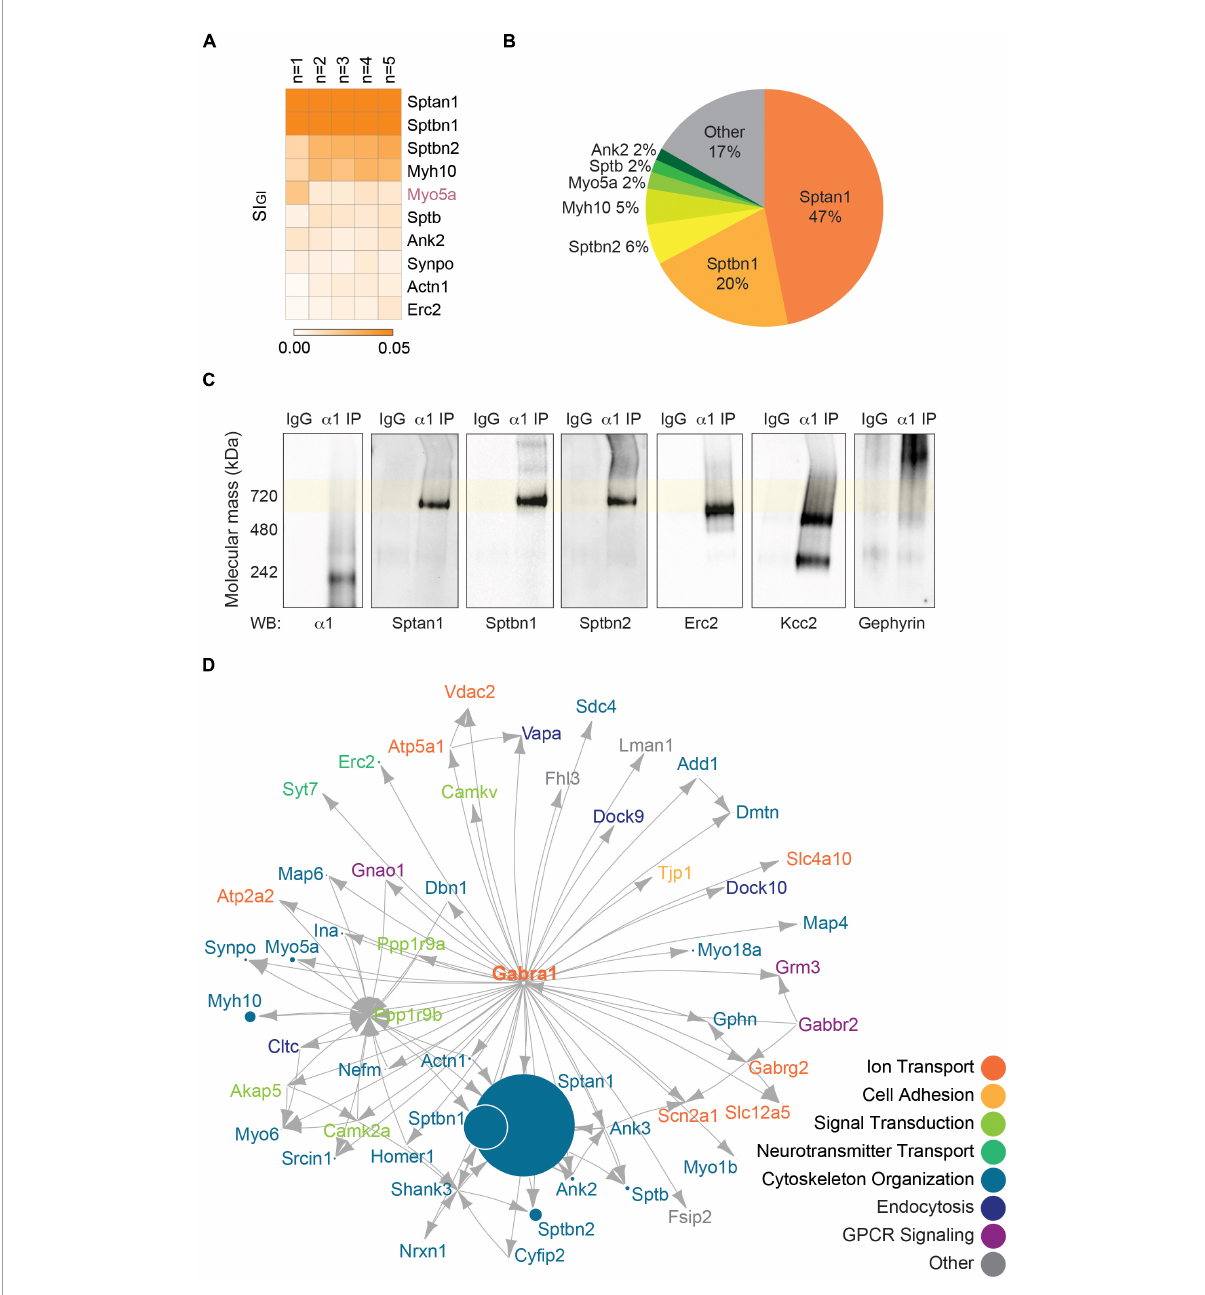
FIGURE2 The endogenous α 1 subunit interacts with inhibitory scaffolding proteins and cytoskeletal proteins. (A) The 720 kDa band of α 1-containing GABA A Rs purified from PM was subjected to LC-MS/MS. Label-free normalized quantification and Welch’s t -test against non-immune control IgG revealed 93 significantly enriched binding proteins of the α 1 subunit. The heatmap shows the top 10 binding proteins of α 1-containing GABA A Rs by abundance (SI GI value) across all replicates. The most abundant proteins detected with the α 1 subunit are Sptan1, Sptbn1, and Sptbn2 ( n = 5 replicates). (B) Pie chart shows the relative abundance of the proteins that are significantly enriched with α 1-containing GABA A Rs. Sptan1, Sptbn1, and Sptbn2 together constitute more than 70% of the total amount of proteins. Proteins that make up less than 2% of the total amount of proteins (86 proteins) were grouped together as ‘Other.’ (C) Immunopurified α 1-containing GABA A Rs were resolved on BN-PAGE and probed for the α 1 subunit, high-abundance proteins (Sptan1, Sptbn1, and Sptbn2), and low-abundance proteins (Erc2, Kcc2, and gephyrin). Sptan1, Sptbn1, and Sptbn2 are observed at around 720 kDa with α 1-containing GABA A Rs. Erc2 and Kcc2 are present slightly below 720 kDa and gephyrin is observed higher than 720 kDa. The immunoreactivity of these proteins is specific to purified α 1-containing GABA A Rs. (D) The network analysis shows known inhibitory scaffolding proteins such as Actn1, Cyfip2, and Gphn (gephyrin), and a subnetwork of spectrins (Sptan1, Sptbn1, Sptbn2, and Sptb) and ankyrins (Ank2 and Ank3). GO analysis reveals that most proteins are involved in cytoskeletal organization, ion transport, or signal